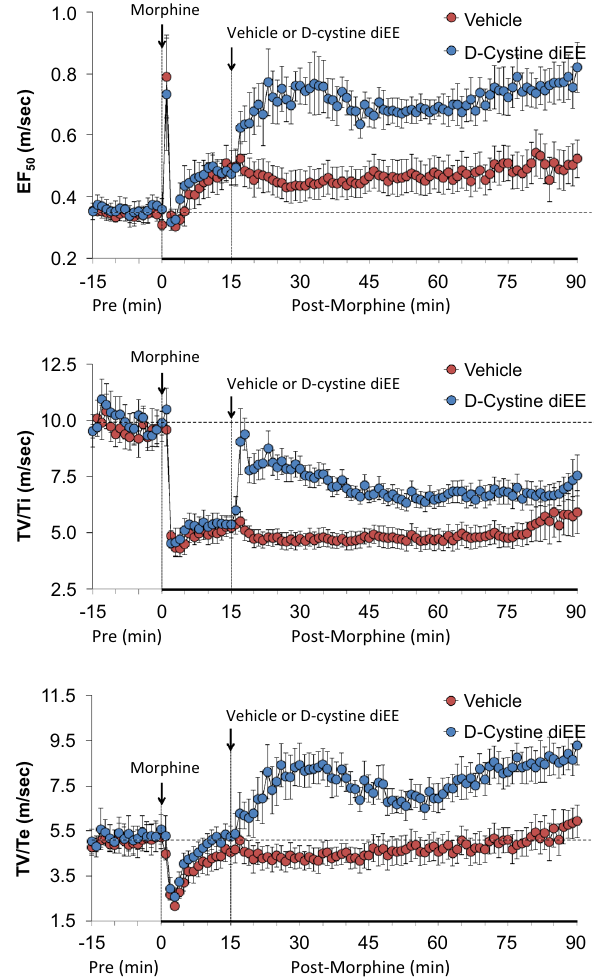
Figure 4. Changes in EF 50 (top panel), inspiratory drive (TV/Ti) (middle panel) and expiratory drive (TV/Te) (bottom panel) in freely moving rats upon (a) injection of morphine (10 mg/kg, IV) and subsequent injection of vehicle (saline) or d-cystine diethyl ester (d-cystine diEE, 500 μmol/kg, IV). The data are presented as mean ± SEM. There were 9 rats in each